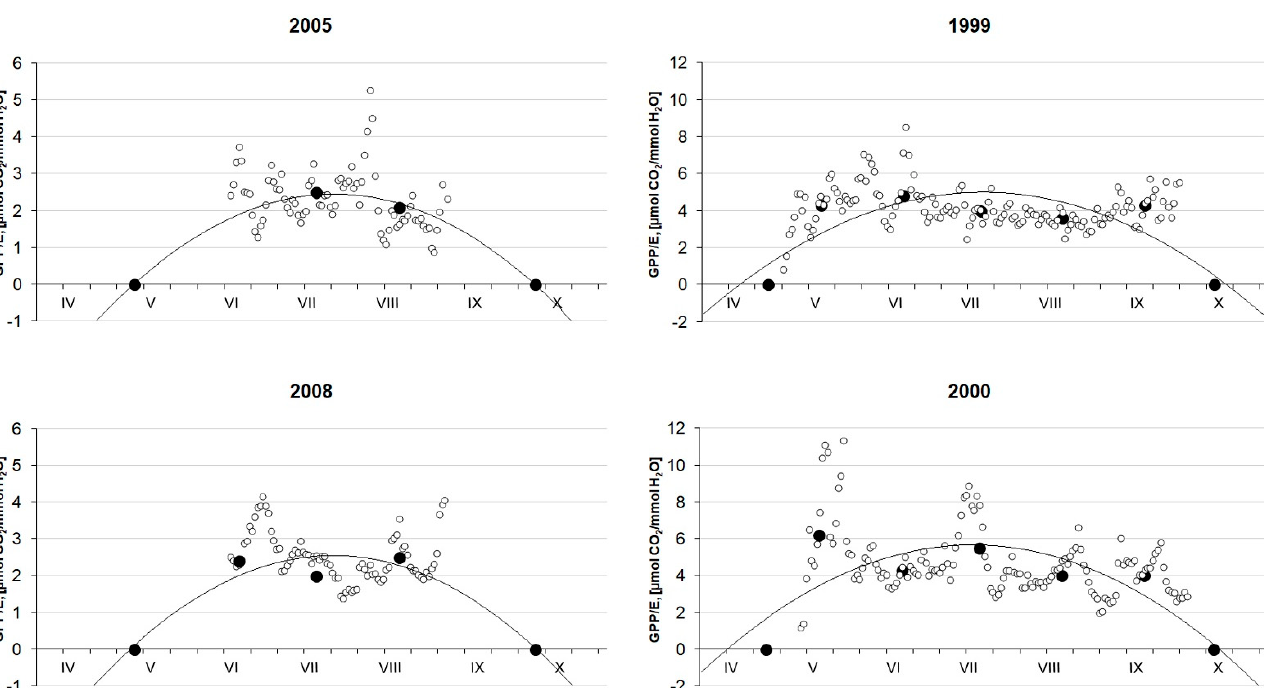
Figure 8. Water use efficiency (GPP/E) in dry (1999 and 2005) and wet (2000 and 2008) years in the Gmelin larch forest ( left ) and Scots pine forest ( right ) during May—September (V–IX).